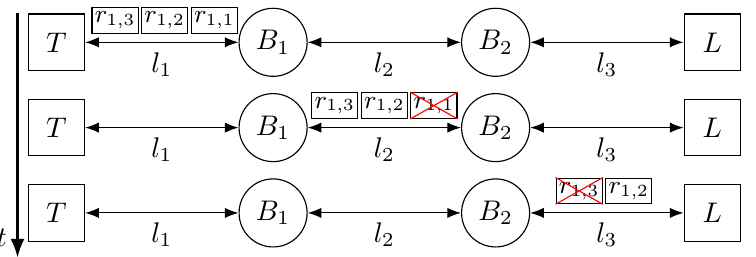
Figure 5. Behaviour of the approach A of the PTRF mechanism in the presence of temporary faults in the